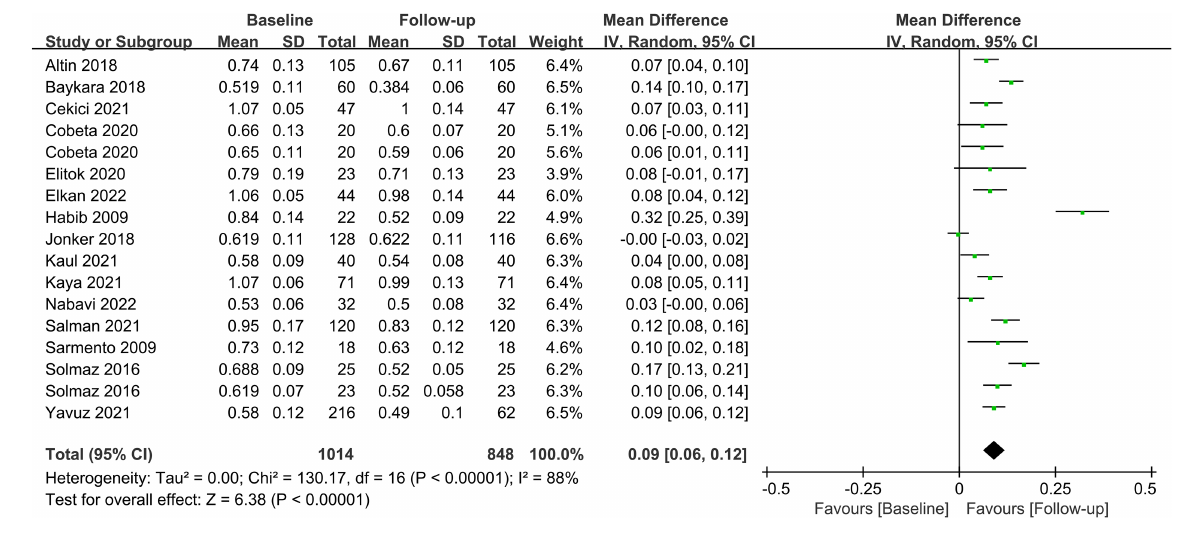
FIGURE 2 Forest plot of meta-analysis of CIMT at 6 months after bariatric surgery. (Cobeta 2020 and Solmaz 2016 respectively included two subsets of data for meta-analysis).